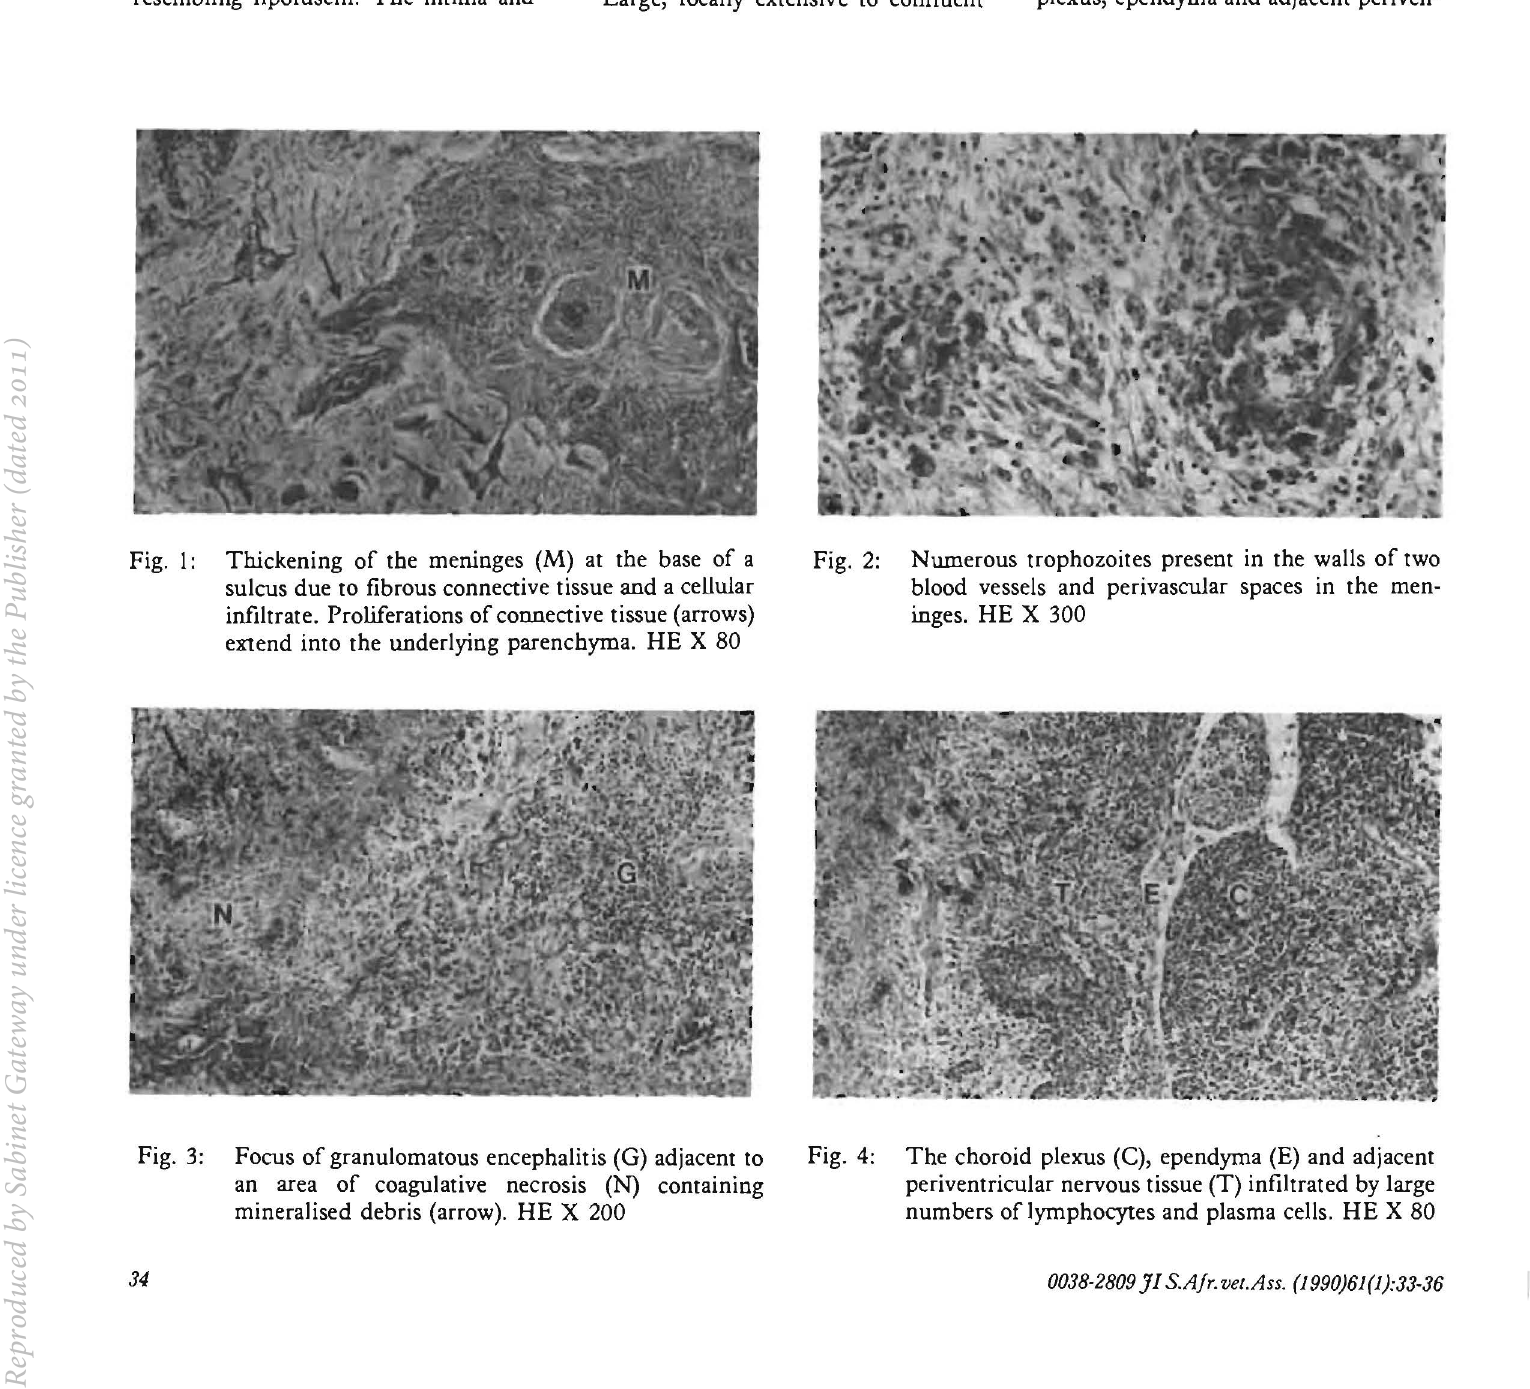
Fig. 3: Focus of granulomatous encephalitis (G) adjacent to an area of coagulative necrosis (N) containing mineralised debris (arrow). HE X 200